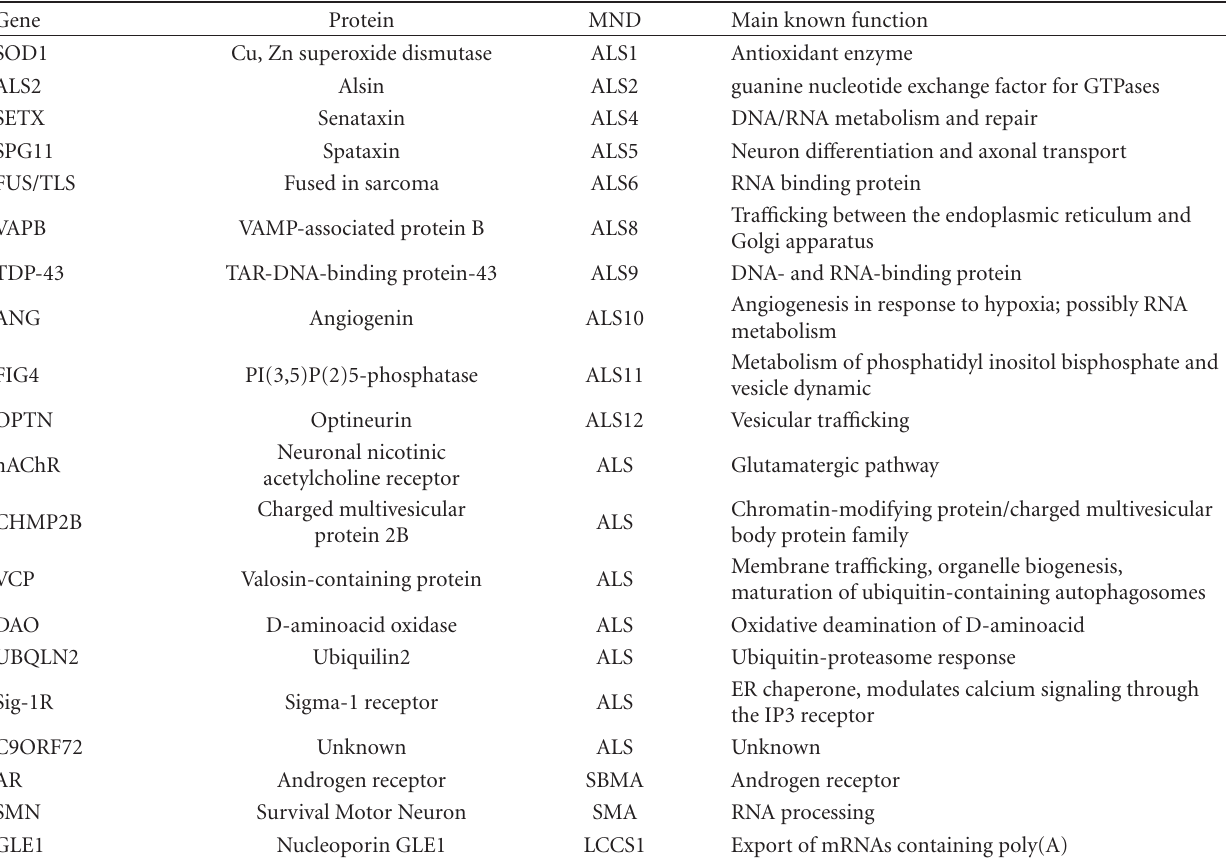
Table 1: Genes involved in